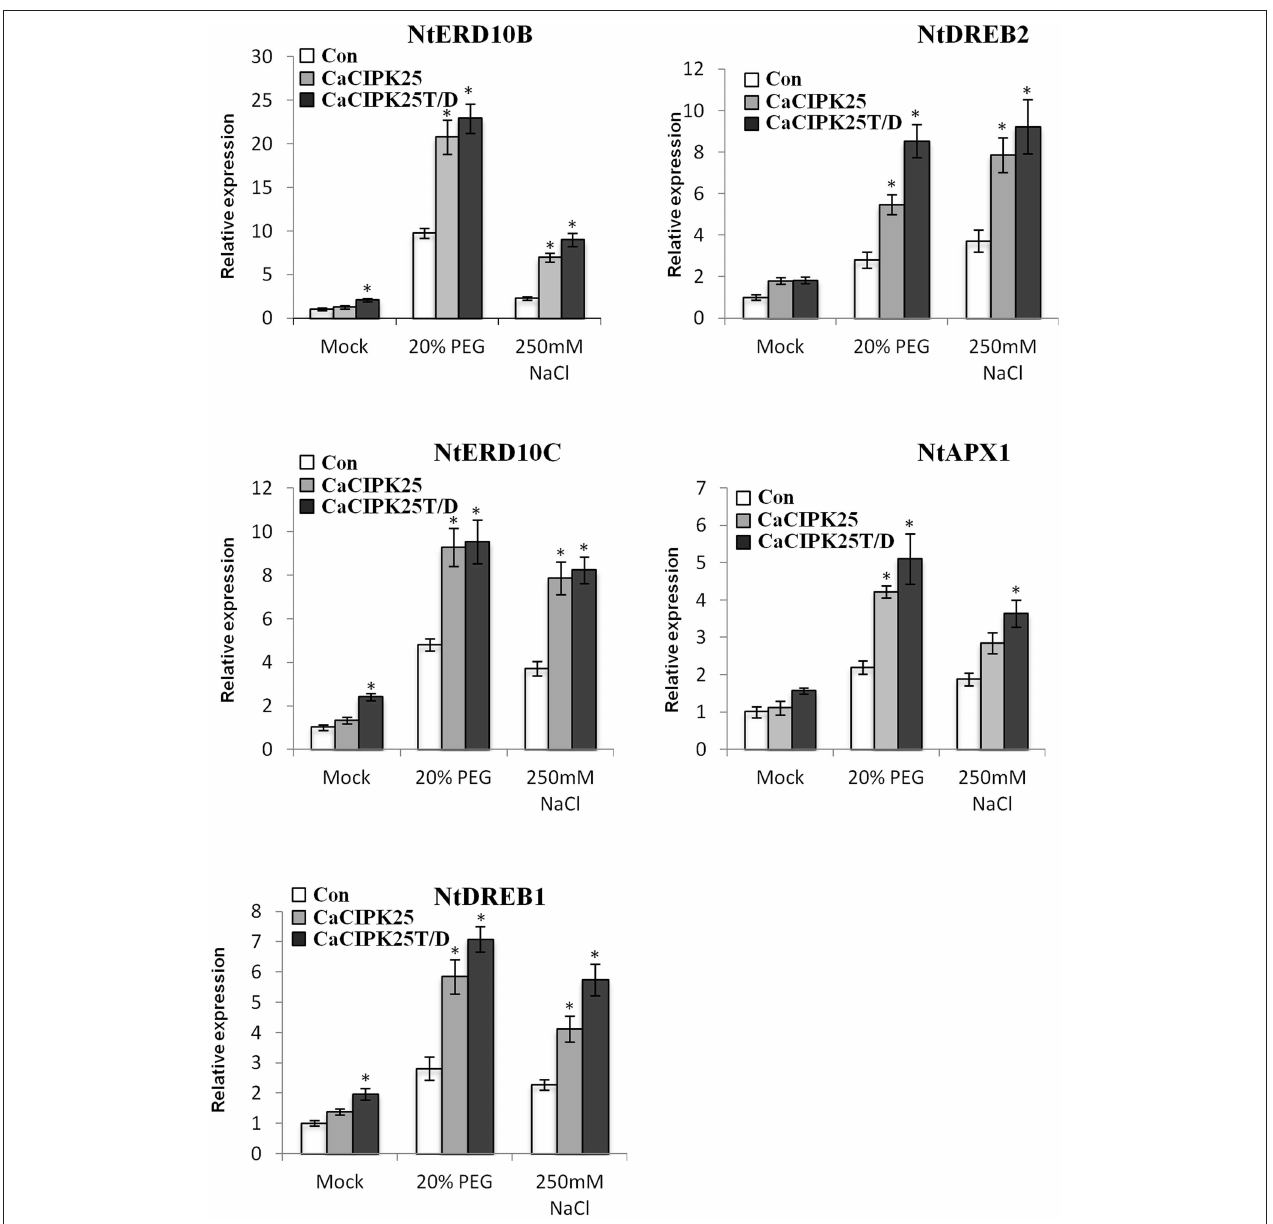
FIGURE 9 | Expression analysis of abiotic stress marker genes in CaCIPK25 overexpressing plants. Expression of known abiotic stress marker genes determined by qRT-PCR in 20-day-old control, CaCIPK25 − and CaCIPK25T/D − overexpressing tobacco plants in response to treatments mentioned. Y-axis described the fold change of expression. Tobacco actin gene was used as internal control. * indicates statistically significant difference ( p < 0 . 05 ) from the control sample.